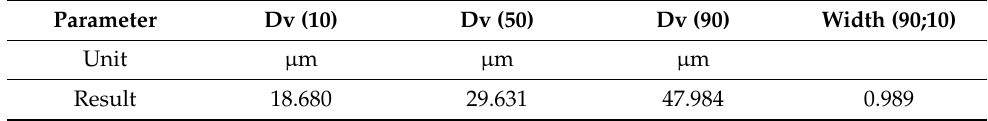
Table 4. Powder size distribution of powders used for the fabrication of samples